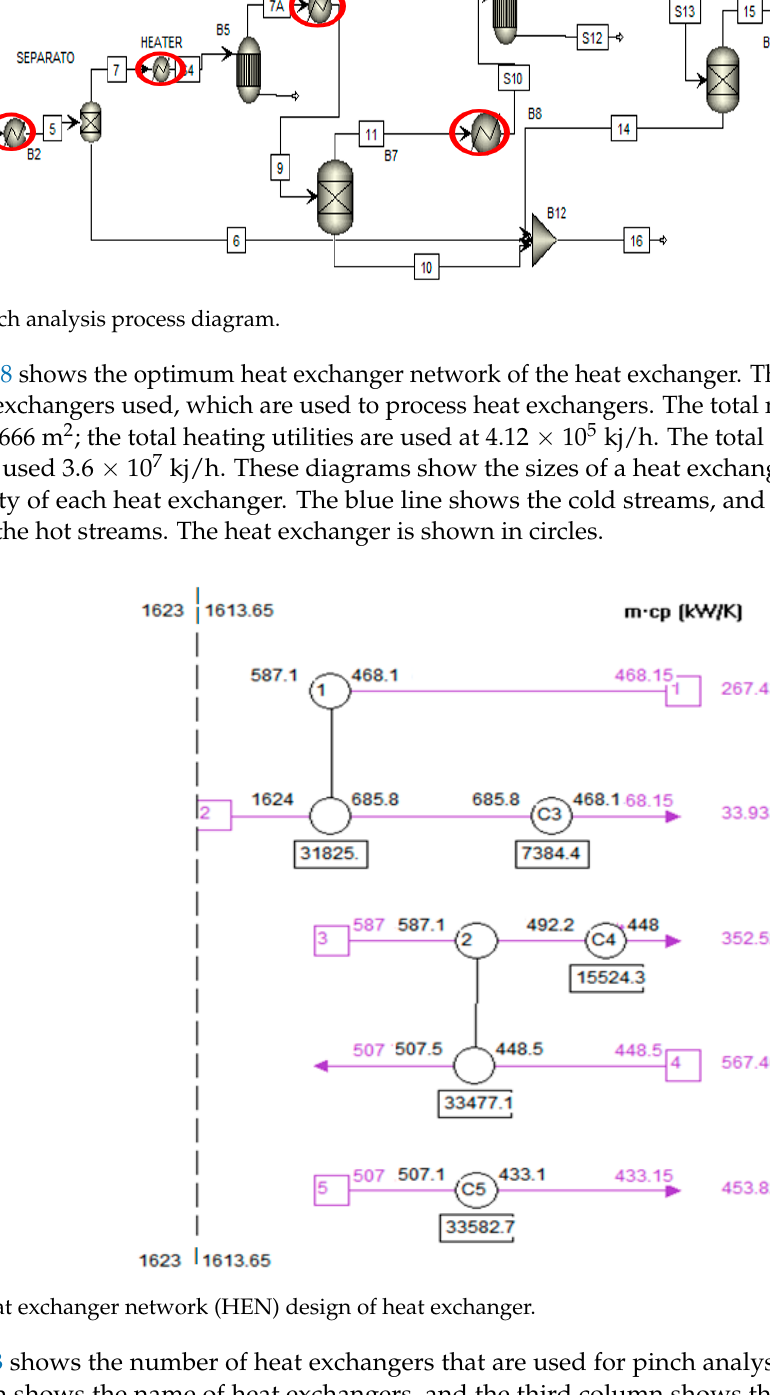
Figure 6. Steps of pinch analysis.